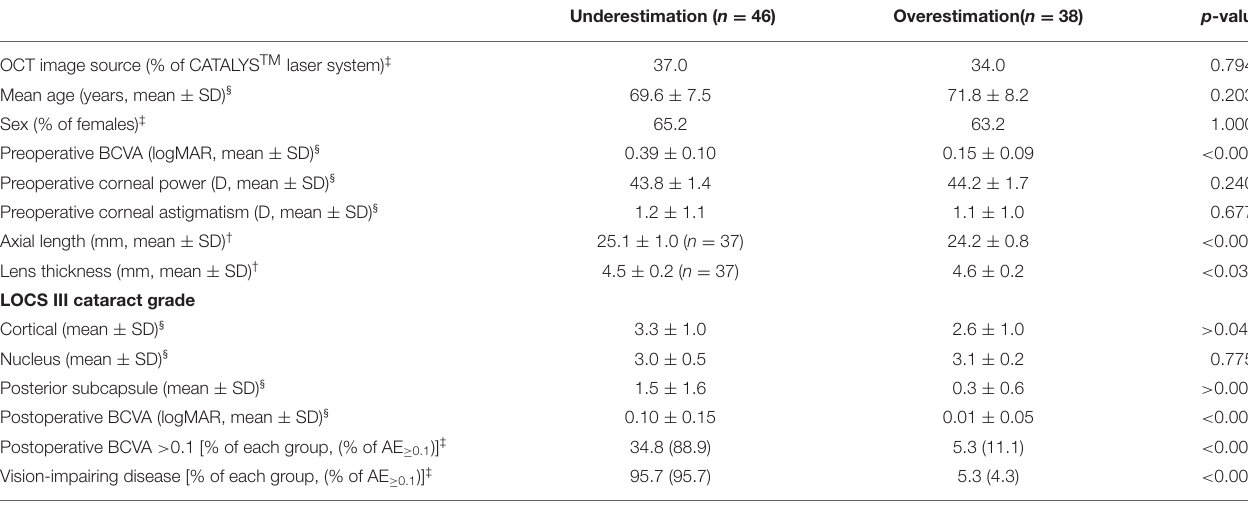
TABLE 4 | Comparison of the overestimation and underestimation groups among patients showing an absolute error of 0.1 and over (AE ≥ 0.1 ) in BCVA.